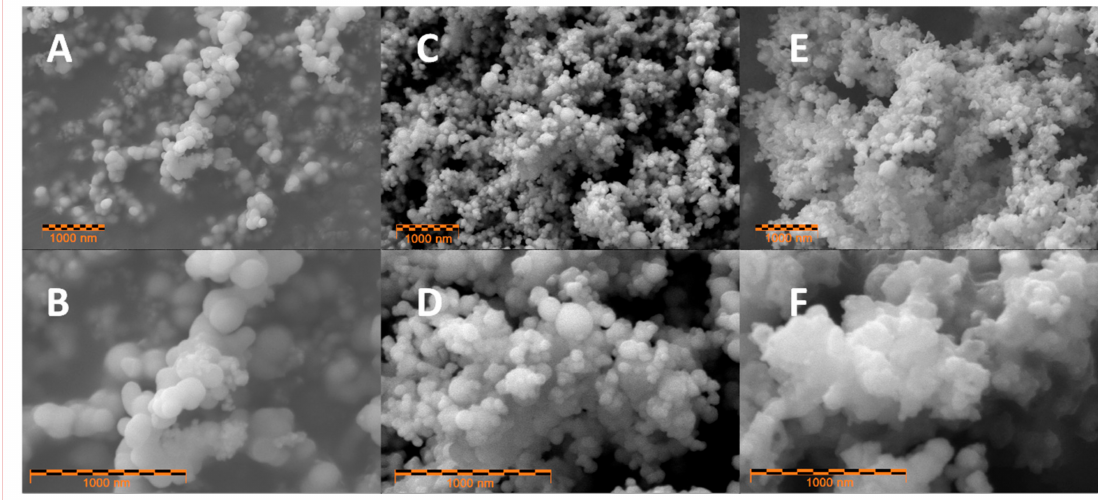
Figure 2. SEM images of pristine Si NPs ( A , B ), Si-1 ( C , D ) and Si-2 ( E , F ) samples. Upper figures— magnification 20,000 × , lower—50,000 ×